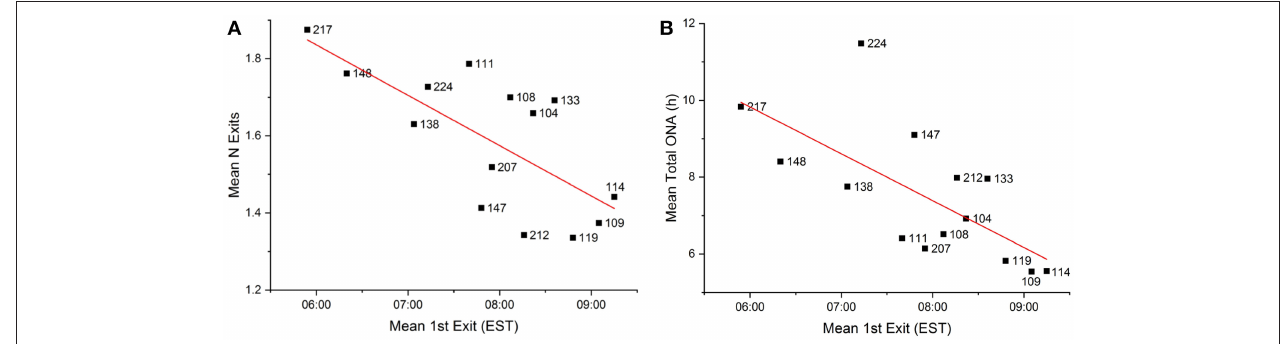
FIGURE 8 | (A) Correlation between the mean timing of first exits and the mean number of exits (modality) of all recorded fox squirrel (numbers) in all seasons (Pearson’s r = − 0.708, p = 0.005). (B) Correlation between the mean timing of first exits and the mean total time spent outside the nest per 24h of all recorded squirrels in all seasons of the year (Pearson’s r = − 0.685, p = 0.007).